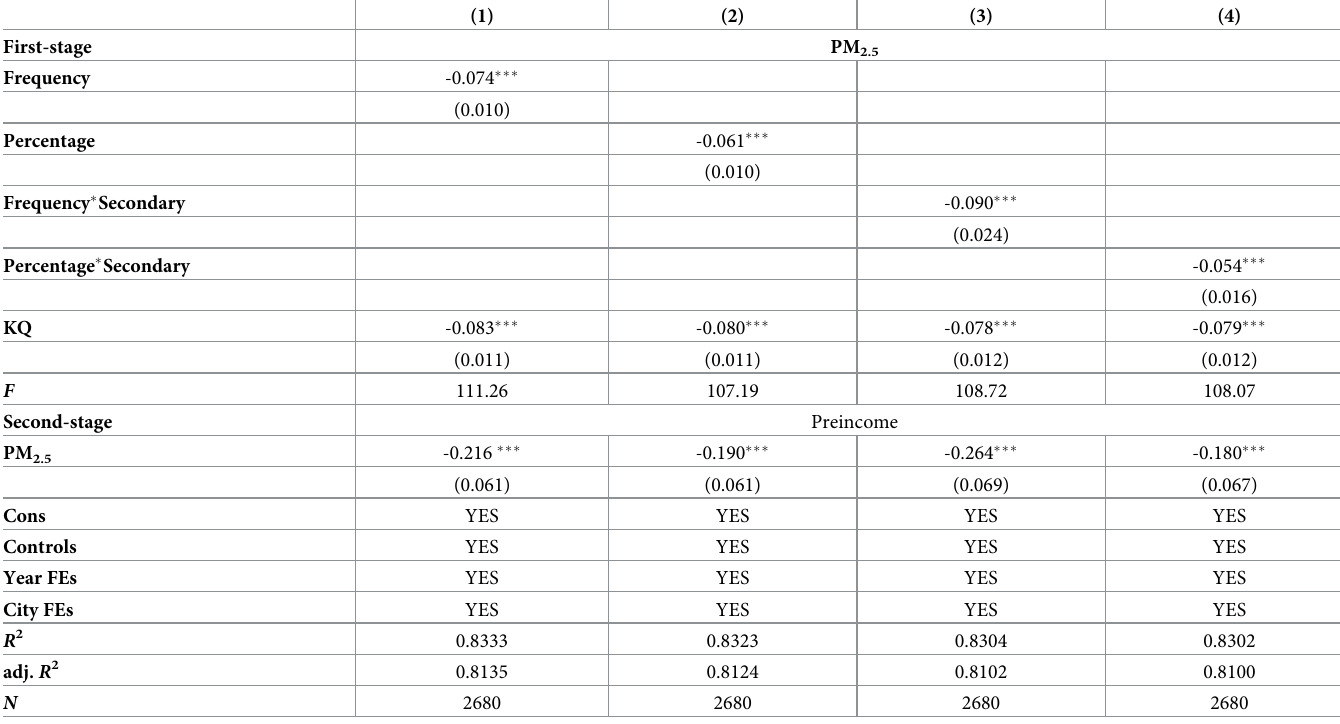
Table 6. Regional governance and insurance development: Instrumental variables